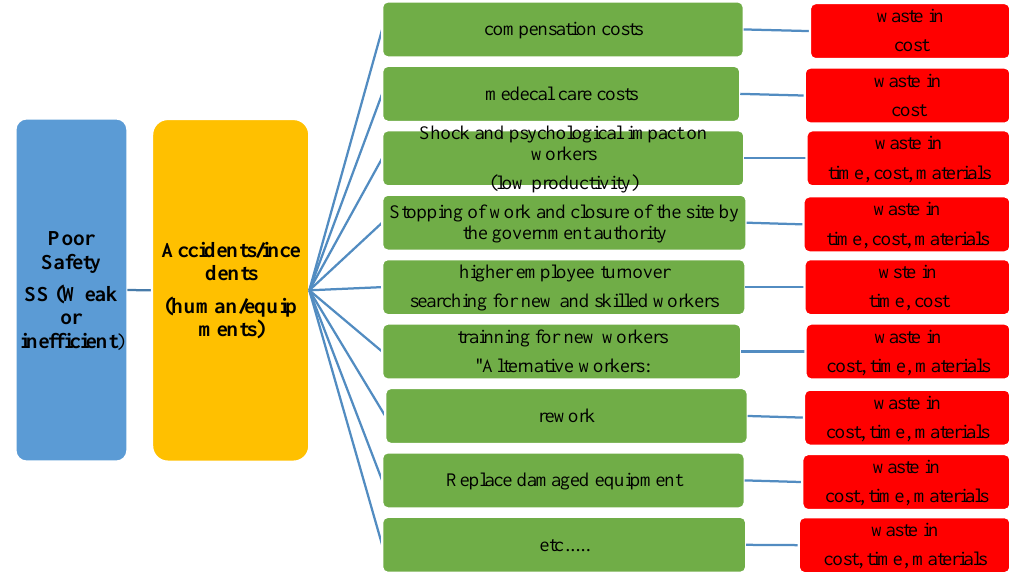
Figure 1. Source of Construction waste (CW).